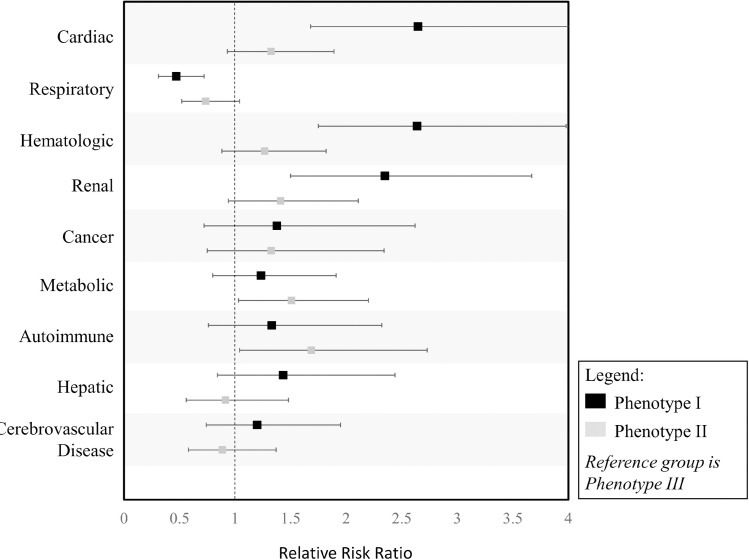
Relative risk ratio of comorbidities to clinical phenotypes.Relative Risk ratios of comorbidities of phenotypes I and II compared to the reference group phenotype III.